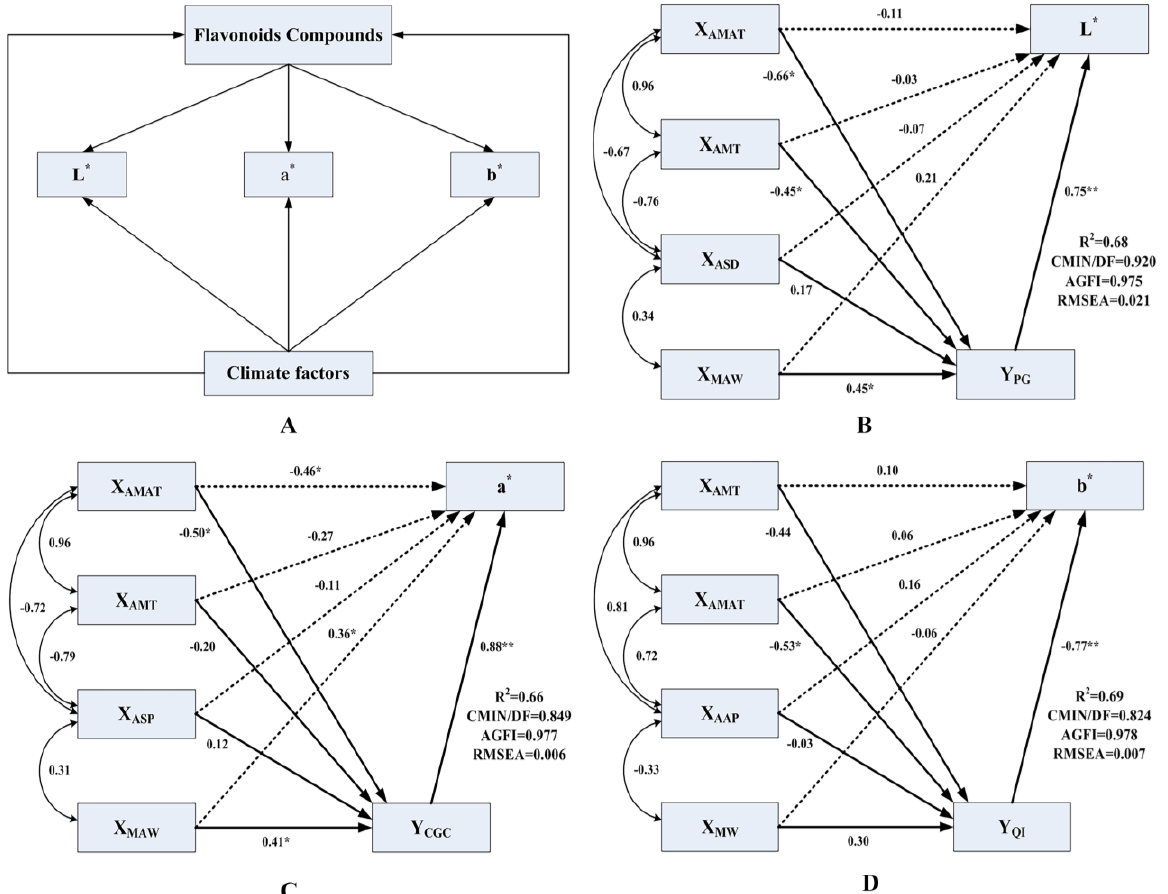
Figure 4. ( A ): The conceptual structural equation modelling was used to examine the linkages amongst climate factors, flavonoids and peel color values. ( B - D ): SEM of the effects of climate factors and flavonoids on peel color in L* ( B ), a* ( C ) and b* ( D ). ** represents significant correlation at p < 0.01 level, * represents significant correlation at p < 0.05 level.